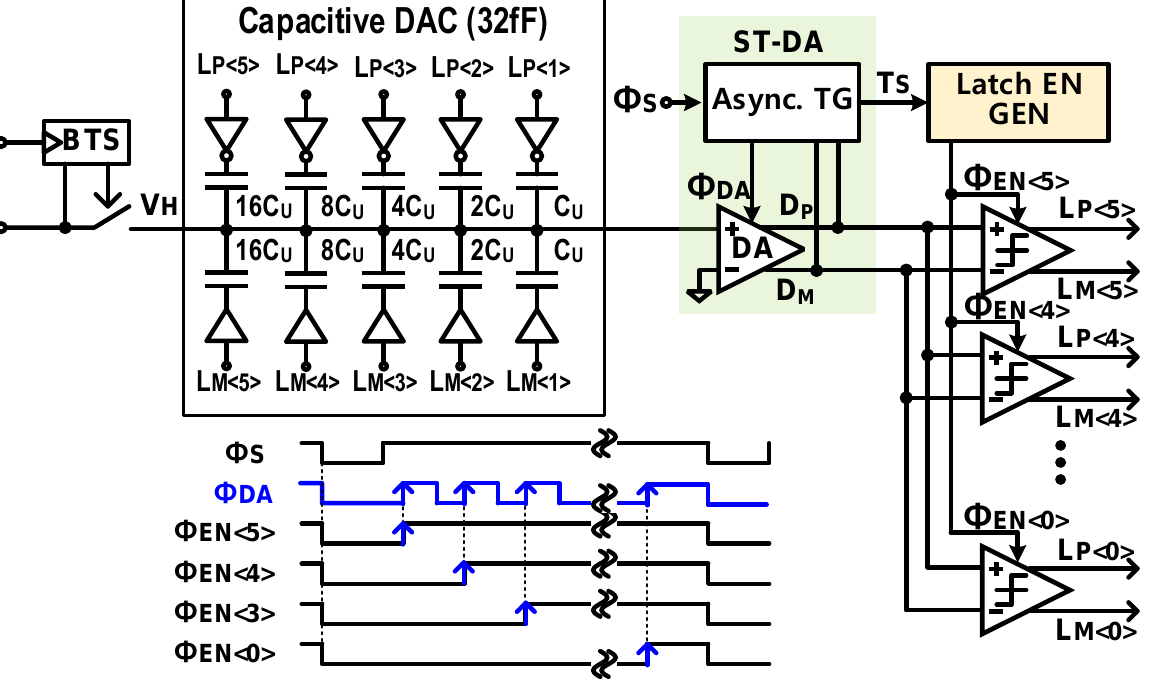
Figure 2. Conceptual block and timing diagram of proposed calibration-free P-LU SAR ADC.